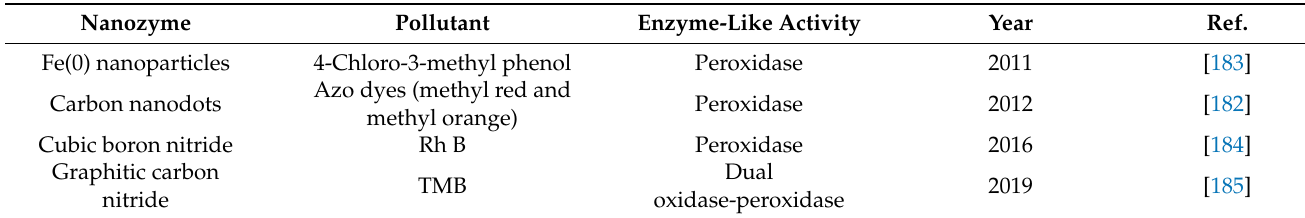
Table 4. Examples of type II nanozymes in environmental pollutant